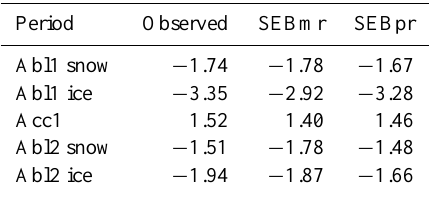
Table 4. Observed and modelled SMB (mw.e) for selected periods between stake measurements in ablation (Abl) and accumulation (Acc) seasons. Figure 4 shows the length of each period.